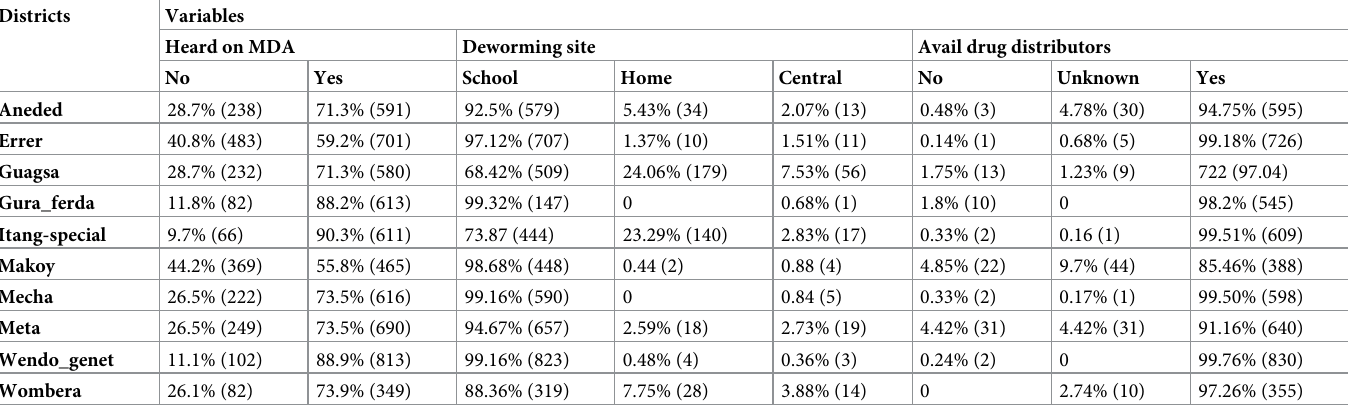
Table 2. Mass drug administration ways in ten districts of Ethiopia, 2019. Districts